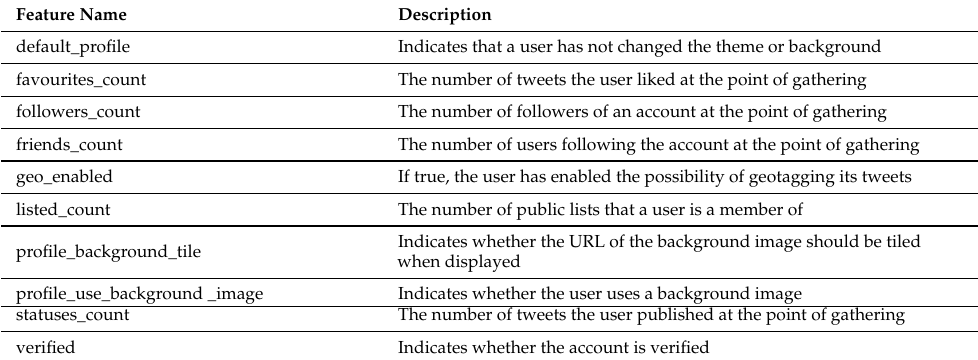
Table A1. Overview of the attributes of a user returned by the Twitter